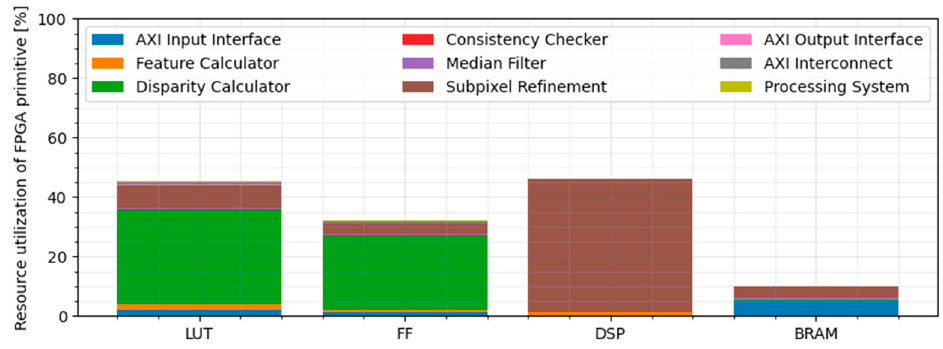
Figure 10. Resource utilization of individual FPGA primitives for the configuration N = 10.